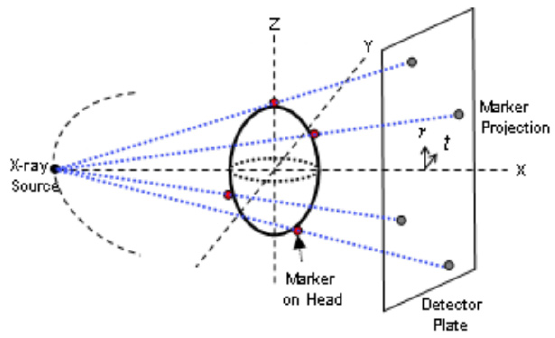
Figure 12. Cone-beam CT assembly with